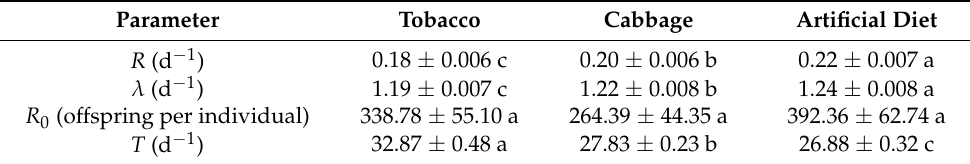
Table 2. Population parameters of Spodoptera litura fed different